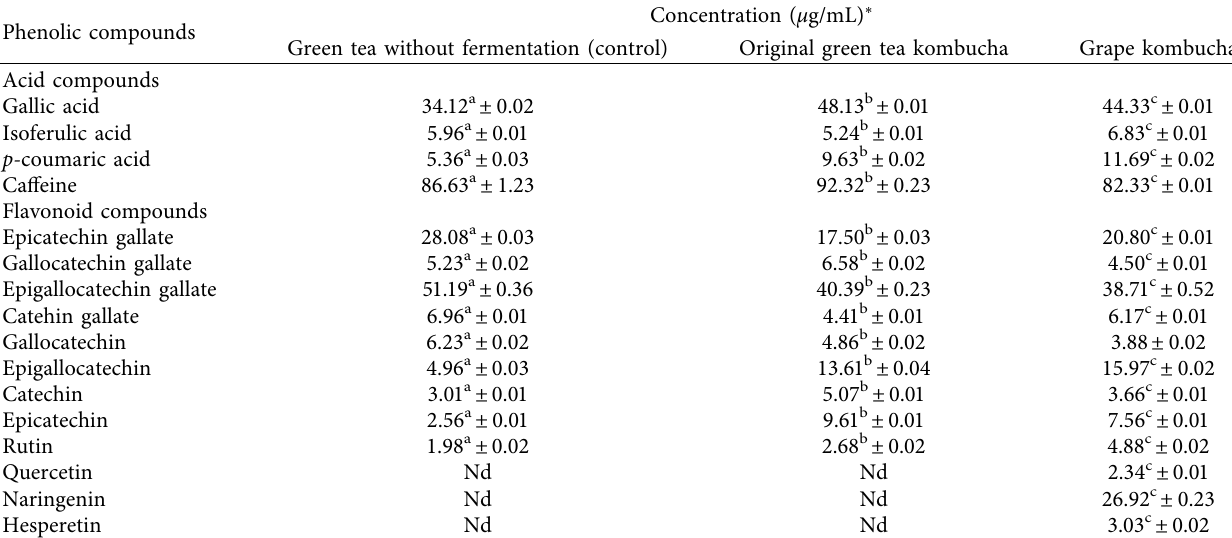
Table 1: The concentration of monomeric phenolic compounds determined in green tea without fermentation (control), original green tea kombucha, and grape